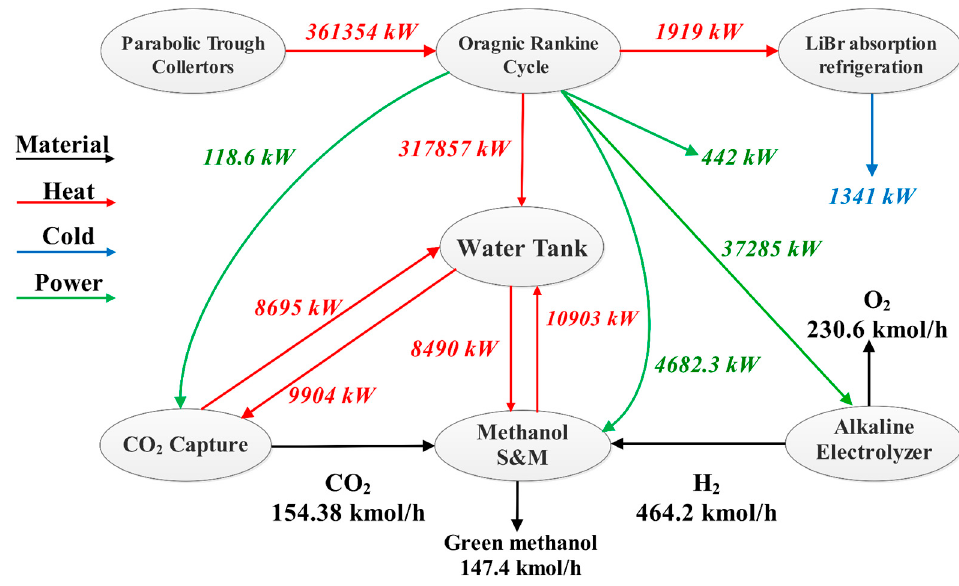
Figure 2. Block diagram of the proposed green poly-generation integrated system.